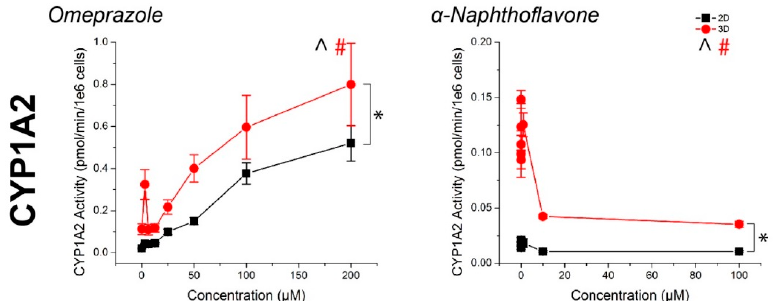
Figure 3. CYP450 activity in primary human hepatocytes in response to known inducers and inhibitors of CYP3A4, CYP2B6, and CYP1A2. Aside from ticlopidine, CYP activities were significantly induced and inhibited as expected. In all cases, higher CYP450 activity was observed in 3D than in 2D. ^, #: p < 0.05 effect of concentration on activity. *: p < 0.05 difference in activity between 2D and 3D. Error bars represent standard error.